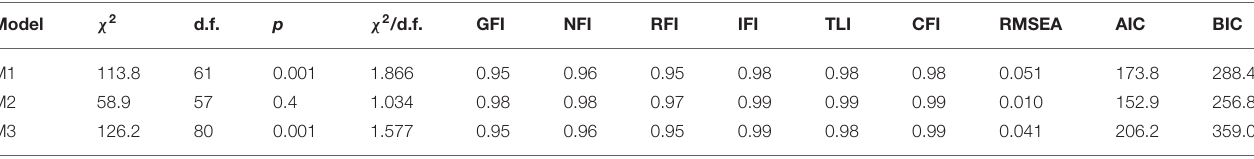
TABLE 2 | Goodness-of-Fit Indices for three models in the PD-patients sample.